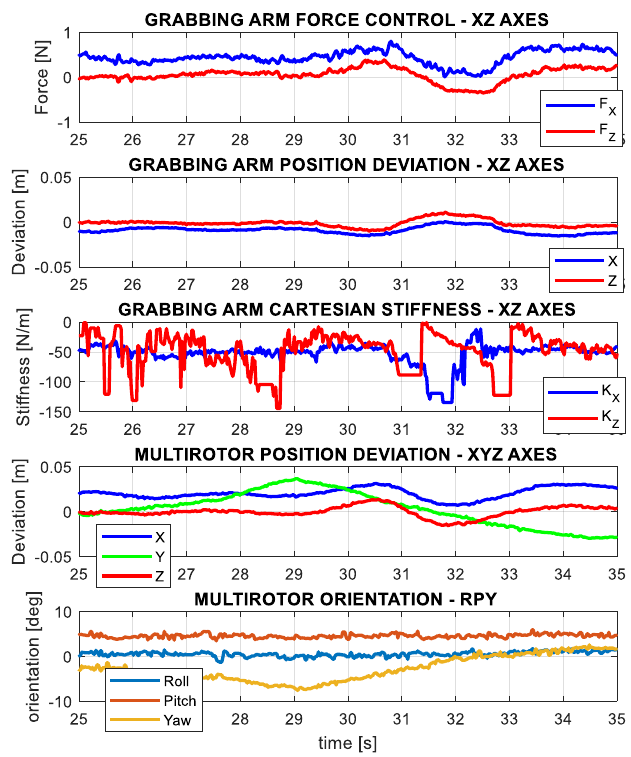
Figure 13. Evolution of the grabbing arm while the multirotor hovers with no disturbance during the grabbing maneuver (phase 5) with impedance control in the x - and z -axes ( K x = K z = 50 N / m ).